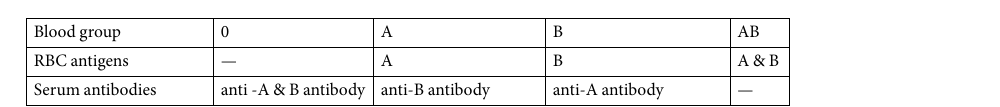
Table 1. Characteristics of the AB0 blood